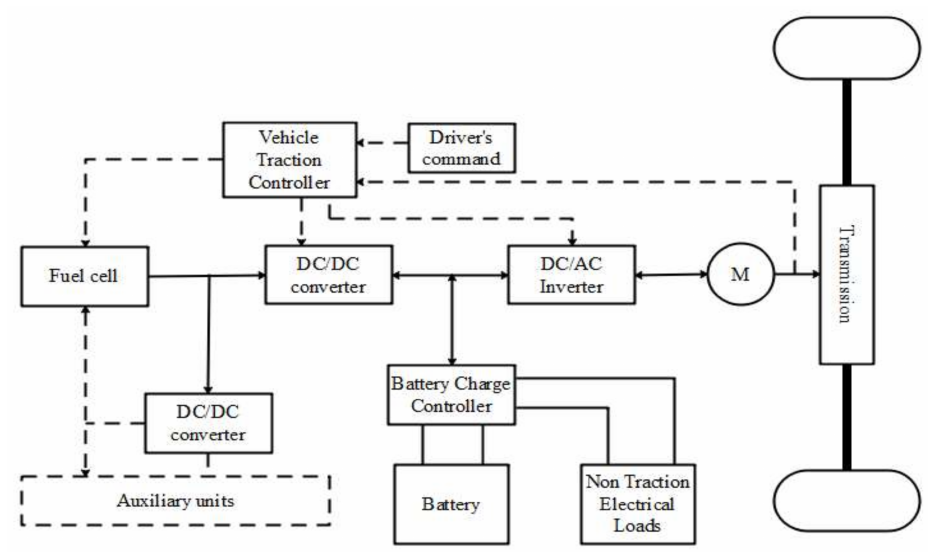
Figure 2. Overall control